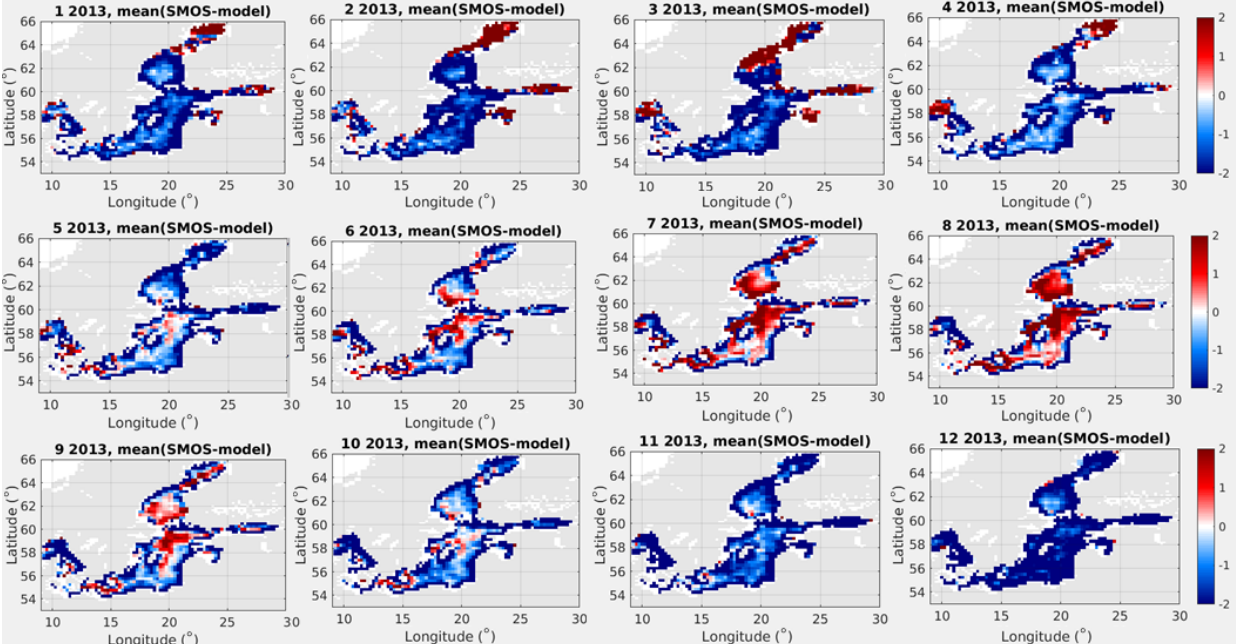
Figure 4. Maps of monthly mean differences between SMOS SSS and the salinity field of CMEMS Baltic reanalysis [psu] for the year 2013.